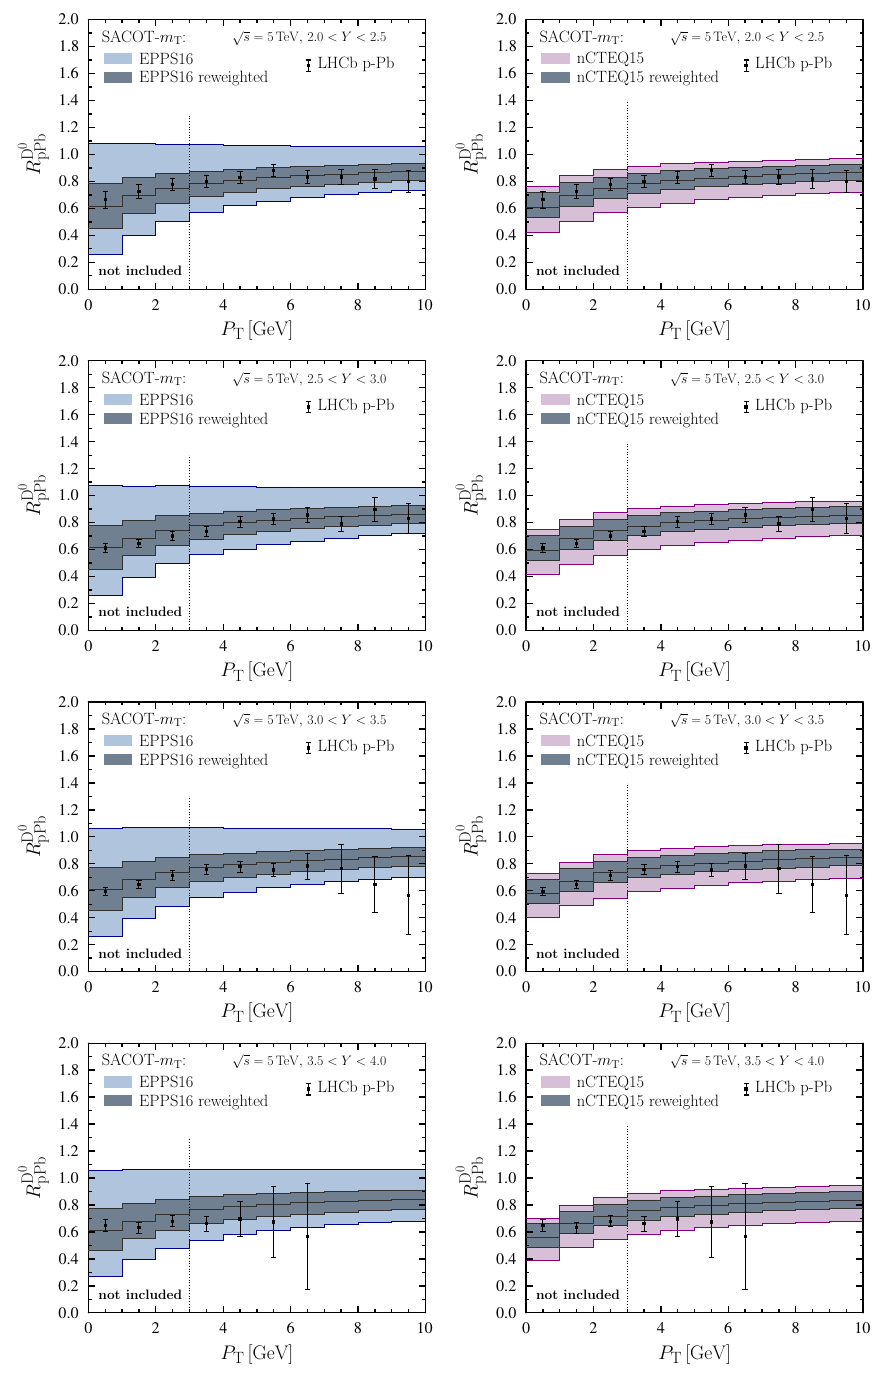
Figure 7 . Same as in (cid:12)gure 6 but at forward